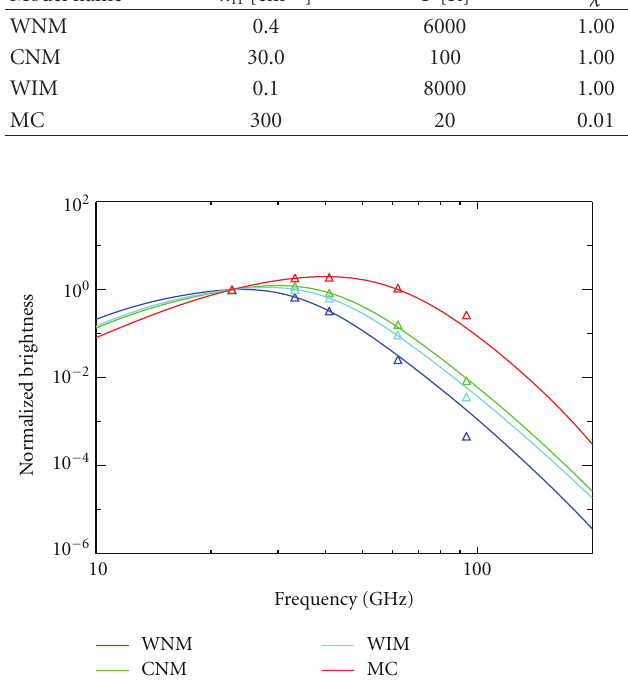
x /n = n C H . We also report the CCA spectral parameters C +